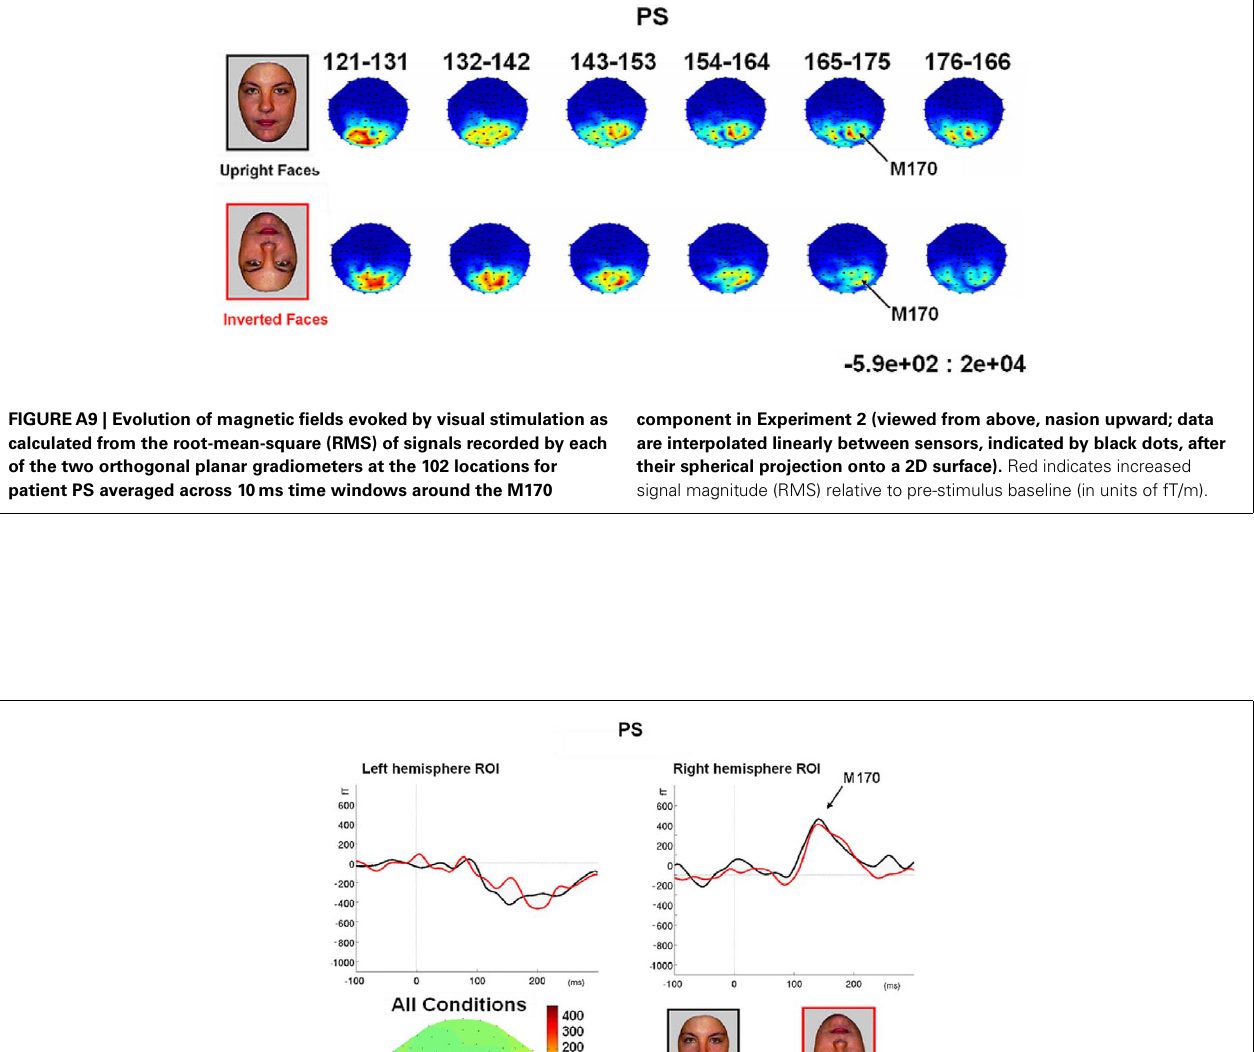
to 190ms, averaged across conditions, highlighted in white on topography below (these are Neuromag channels “MEG2331,” “MEG2511,” and “MEG2521” for the right ROI, and “MEG1931,” “MEG1731,” and “MEG1721” for the left